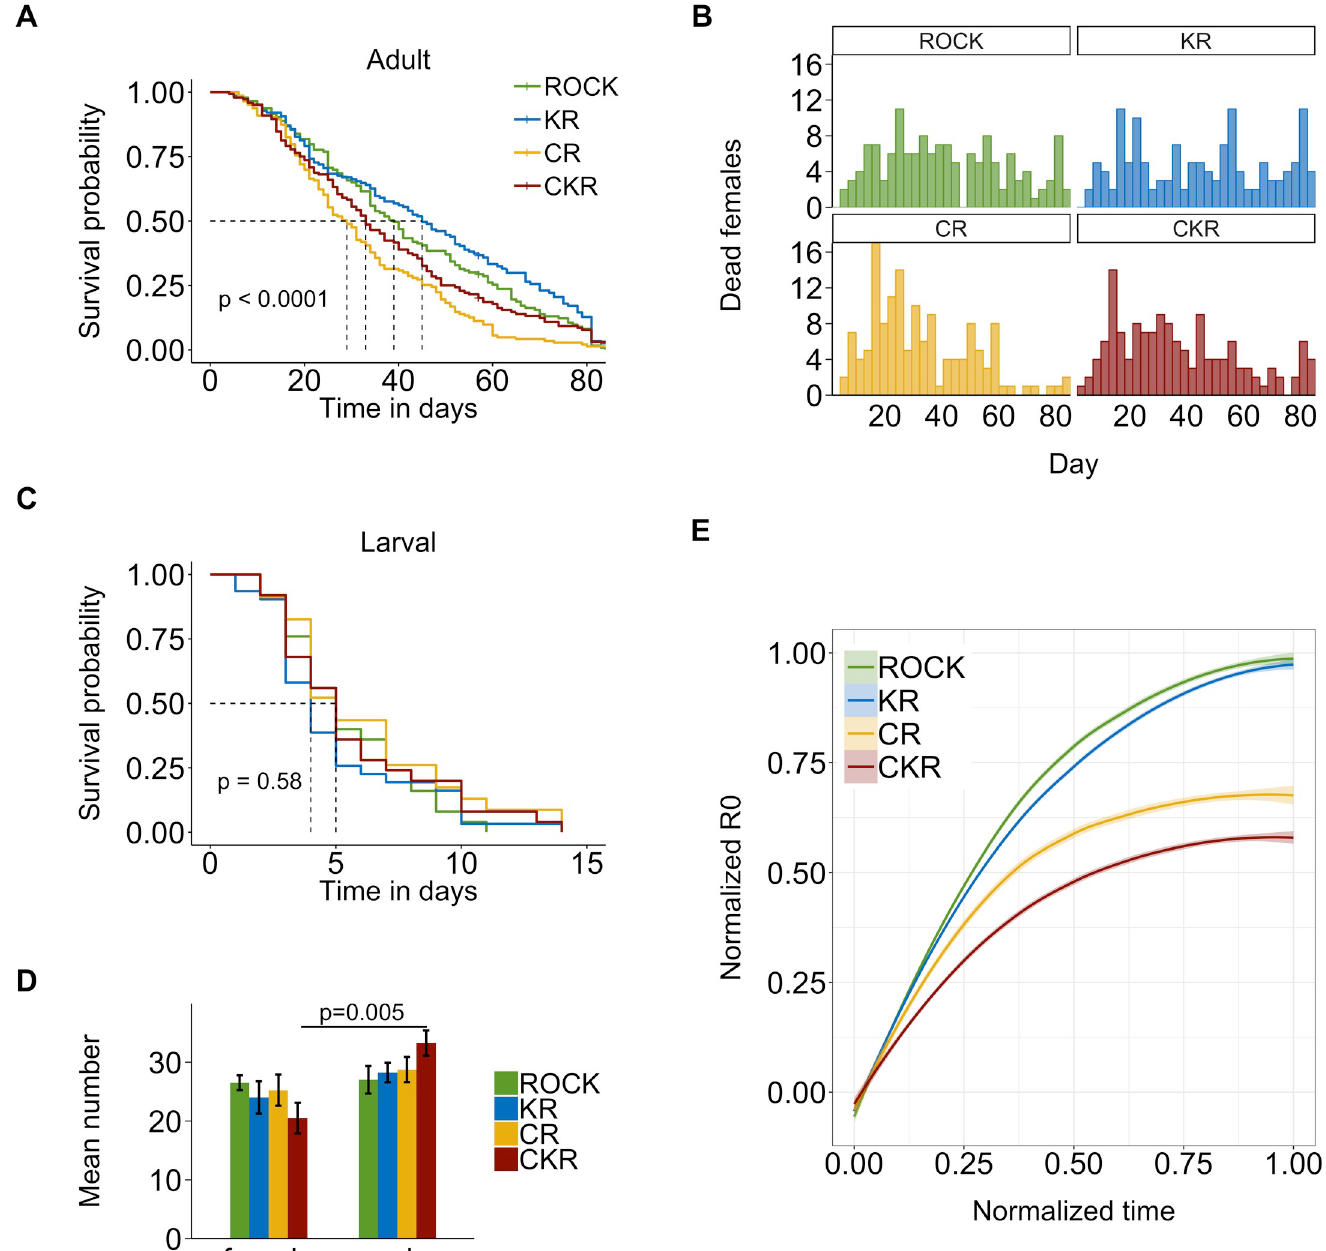
Fig 3. Comparison of life table components in four congenic strains of A . aegypti . (A) Kaplan-Meyer survival plot of females. (B) Average number of dead females per day for each strain. (C) Kaplan-Meyer survival curve of larvae. (D) Mean number of females and males emerged from an equal number of larvae (sex ratio). Bars represent the standard error of the means. (E) Mean R 0 value across three replicates normalized by the highest R 0 and time of each replicate.